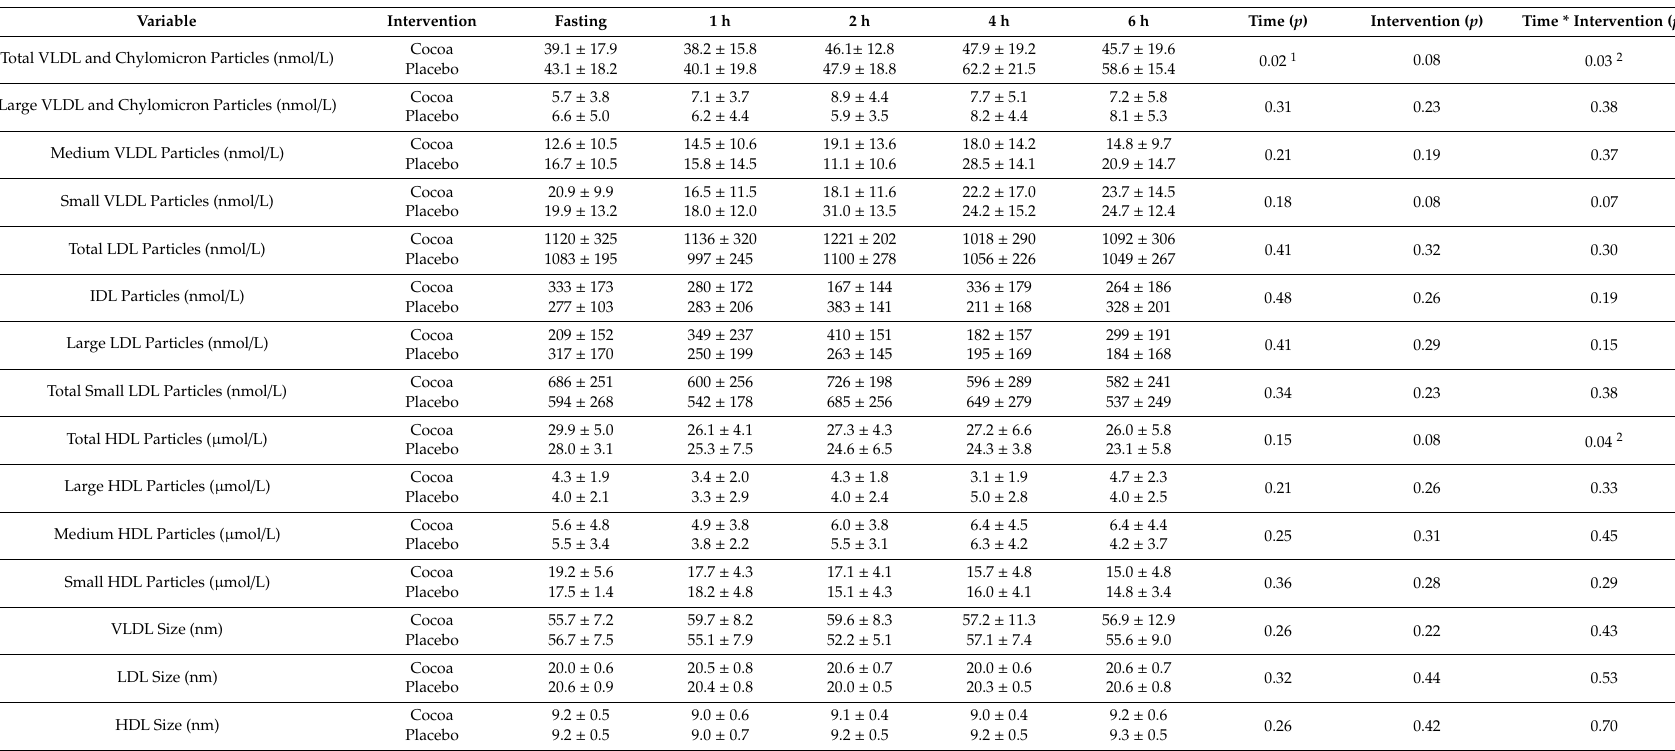
Table 2. Postprandial plasma levels of NMR-derived lipoprotein subclasses in adults with type 2 diabetes following a high-fat meal challenge with polyphenol-rich cocoa or placebo beverage. Variable Intervention Fasting Intervention ( p ) Time * Intervention ( p